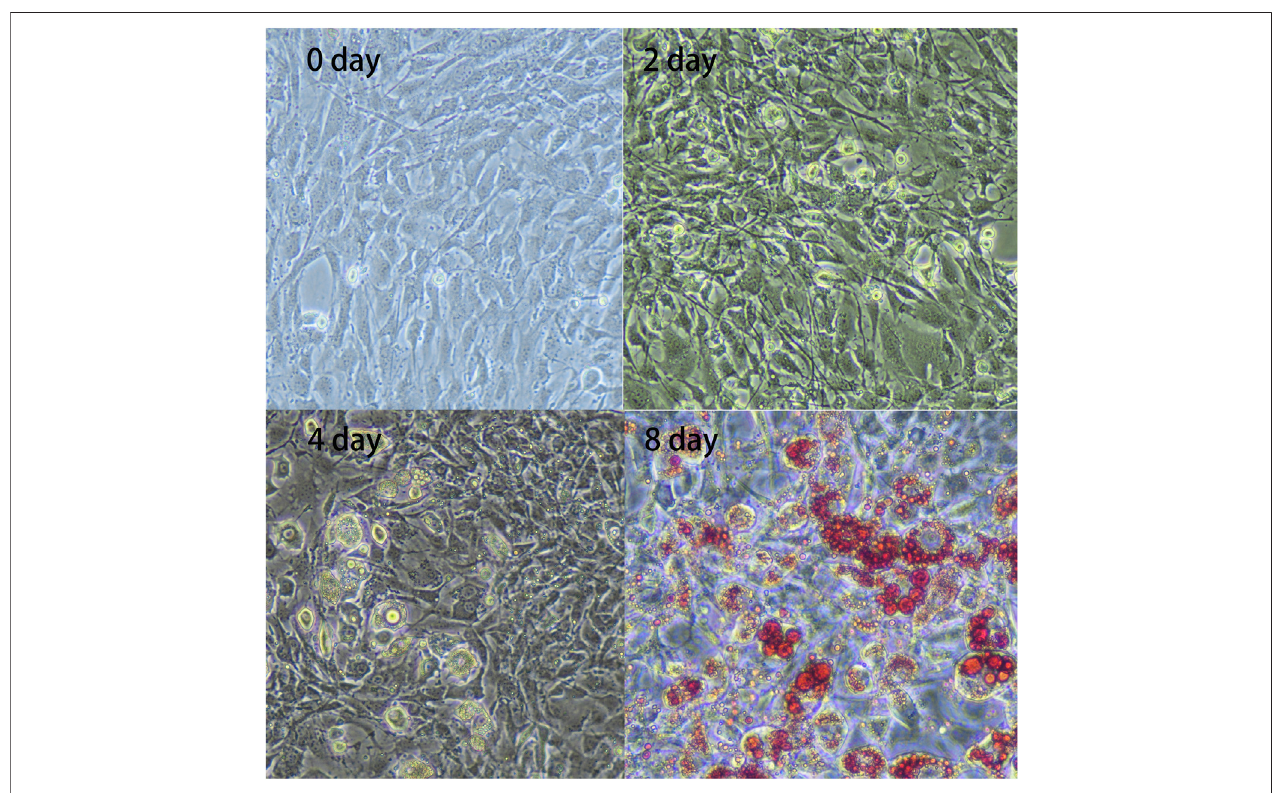
FIGURE 1 | In vitro adipocyte differentiation. Preadipocytes were obtained from the subcutaneous adipose tissue of three 7-day-old Landrace pigs and were cultured and collected at four differentiation stages: 0, 2, 4, and 8 days. The fi gure shows enlarged representative photographs of adipocytes obtained during differentiation [day 0, 2, 4, and 8; day 8 with Oil Red O staining ( ×